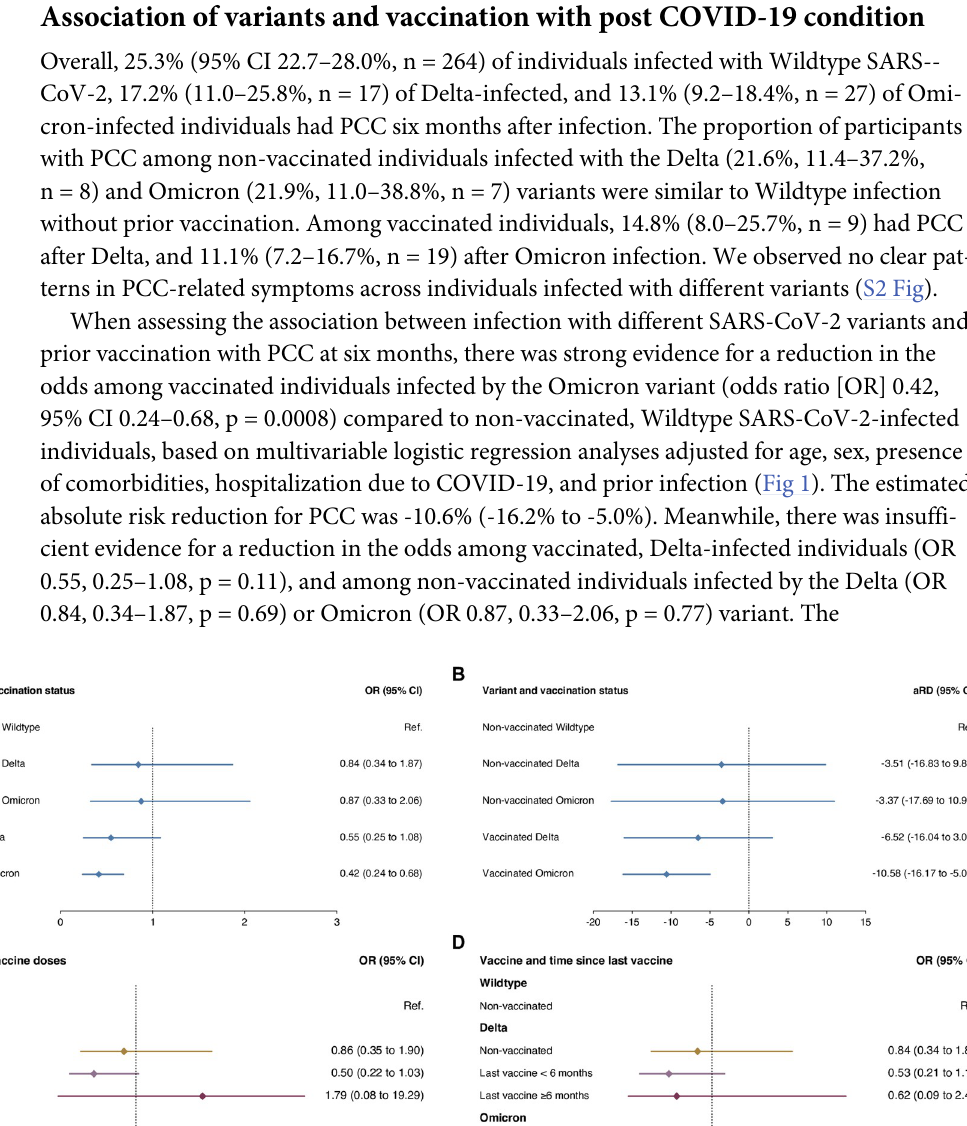
PLOS ONE | https://doi.org/10.1371/journal.pone.0281429 February 22,